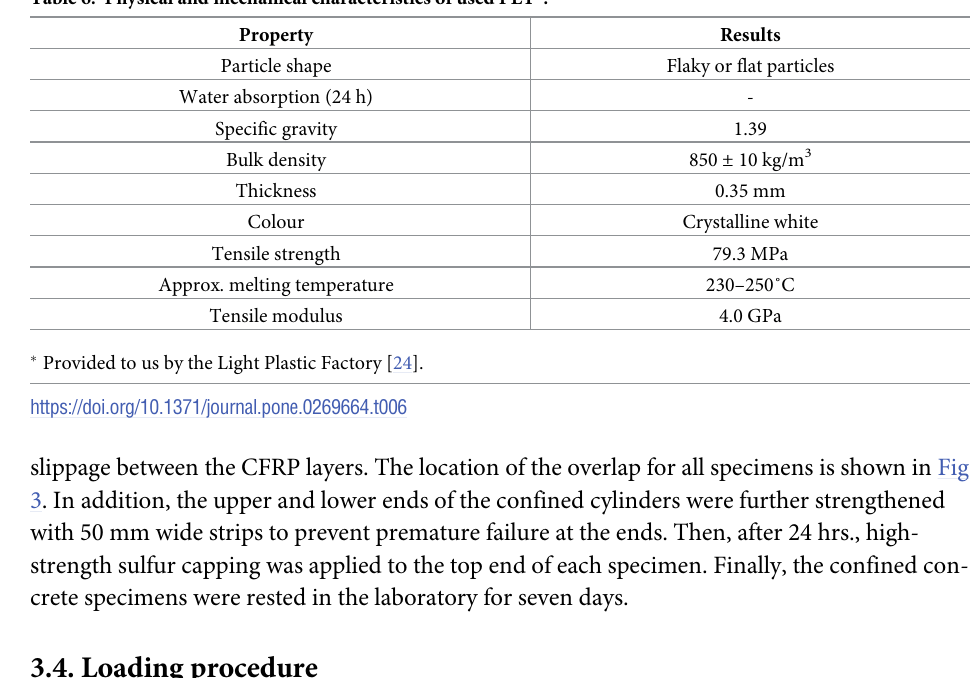
Table 6. Physical and mechanical characteristics of used PET � .